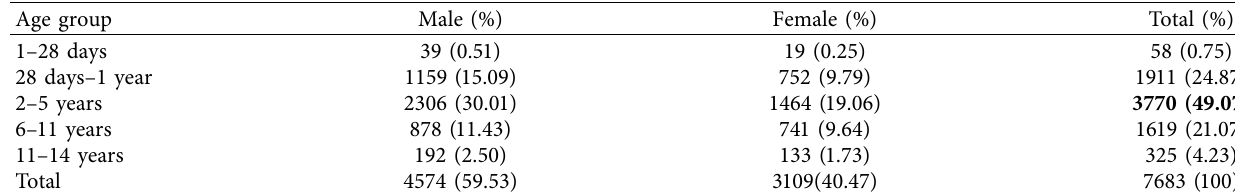
Table 2: Patients’ distribution according to sex and various age groups.